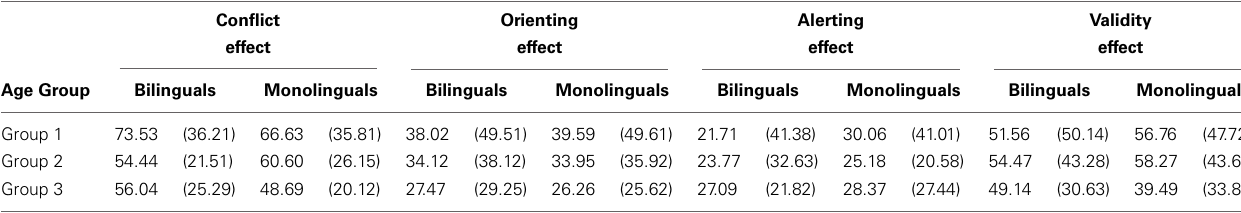
Table 4 | Latency differences in attentional networks in each age